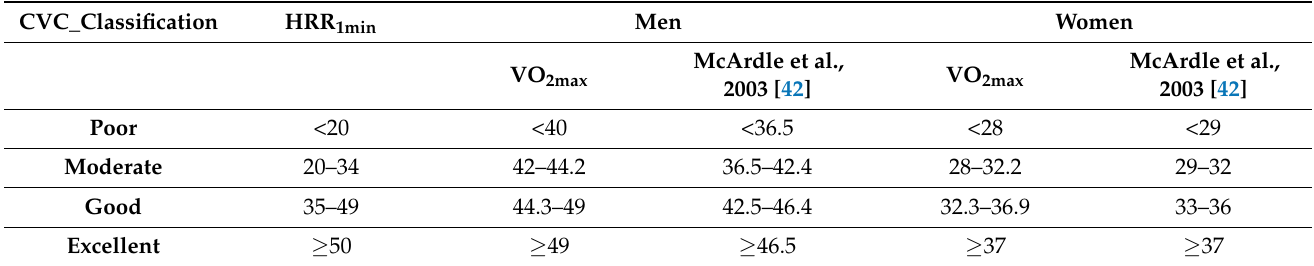
Table 3. Cardiovascular capacity (CVC) classification based on HRR 1min and the respective HRR cut-off values. It also presents the VO 2max values predicted by equation 1 (from our study) and the values proposed by McArdle et al. [41] for similar categories. These values are also used by a company of worldwide repute in the evaluation of body composition (Tanita: https://tanita.eu/blog/ could-improving-your-vo2-max-be-the-secret-of-success (accessed on 28 July 2022)) [42]. These reference values are for the age group 20 to 29